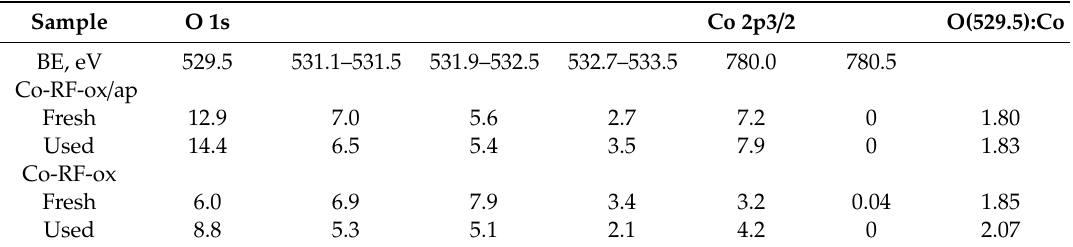
Table 3. Concentrations of cobalt species and O (in at.%) from XPS spectra of the examined